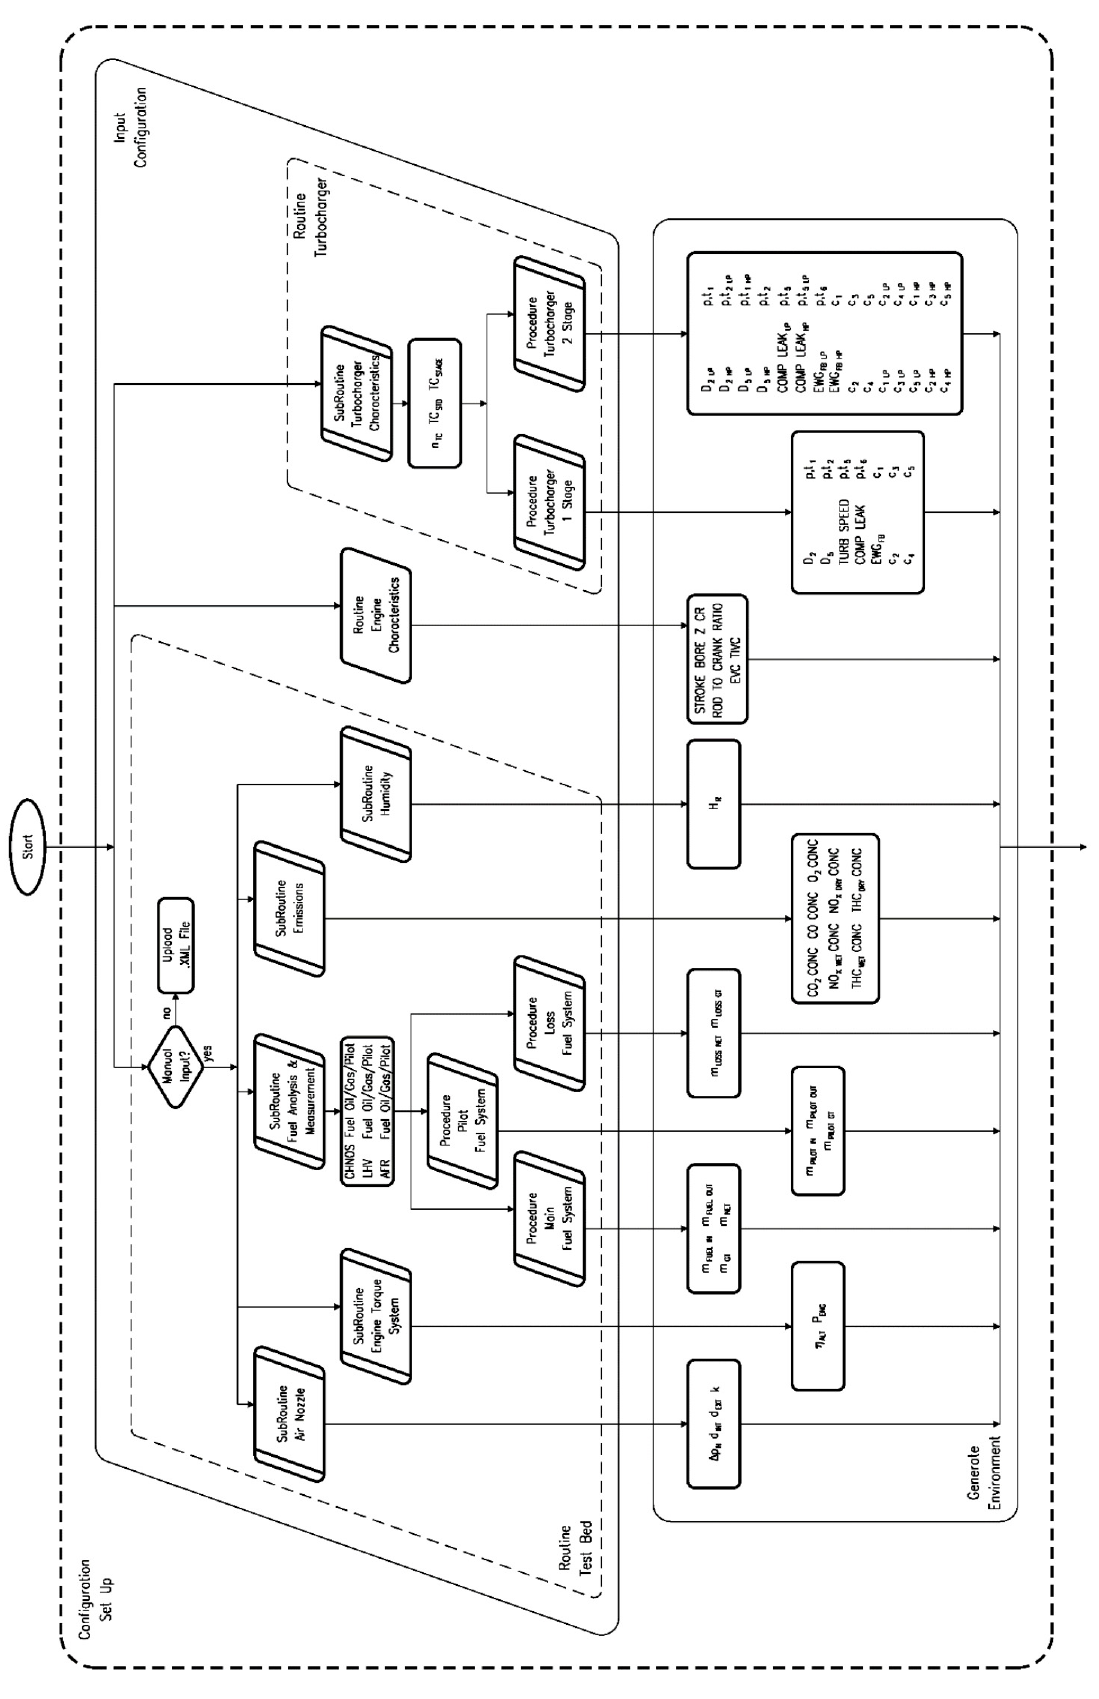
Figure 2. Configuration Set Up phase.